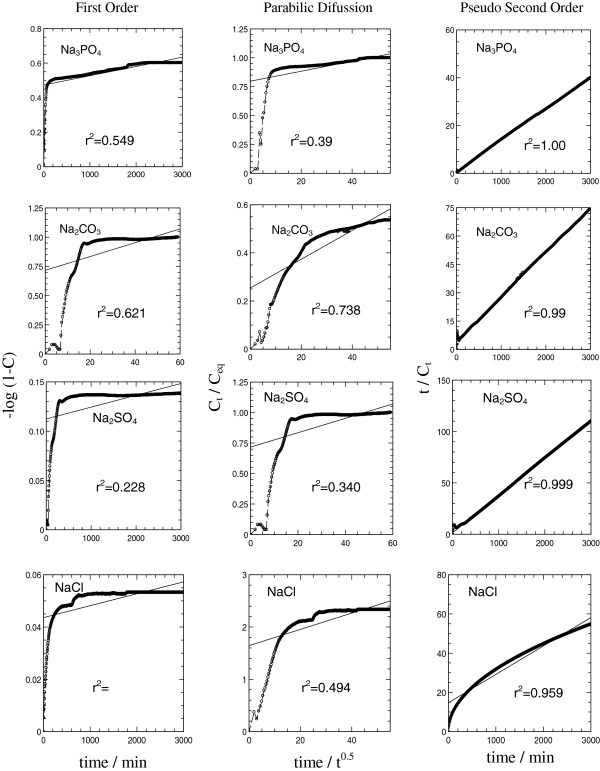
Release profiles of 3,4-D. Fitting the release data of 3,4-D from the nanohybrid into various aqueous media (Na3PO4, Na2CO3, Na2SO4, and NaCl (0.005 M)) using first-order, parabolic diffusion, and pseudo-second-order kinetic models.